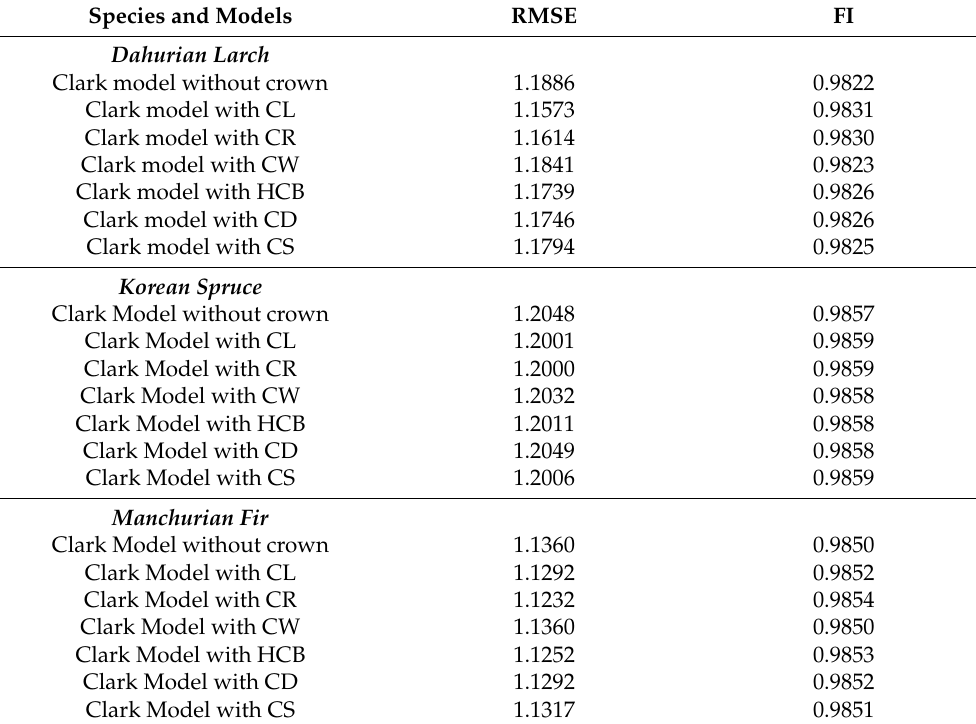
Table 4. Fit statistics for Clark model with and without crown variables by species.